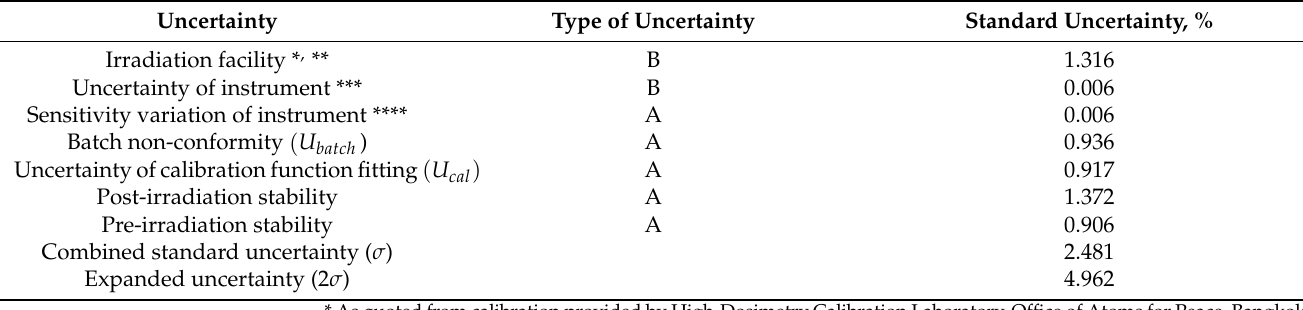
Table 1. Sources of uncertainty associated with absorbed dose measurements by the developed PVA/AgNPs liquid dosimeter in the dose range of 10–100 Gy. Uncertainty Type of Uncertainty Standard Uncertainty, % B